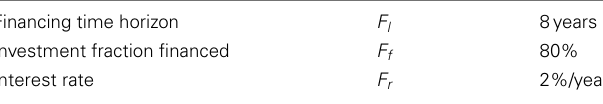
Table 2 |Additional parameters used to compute basic PV electricity costs including financing.